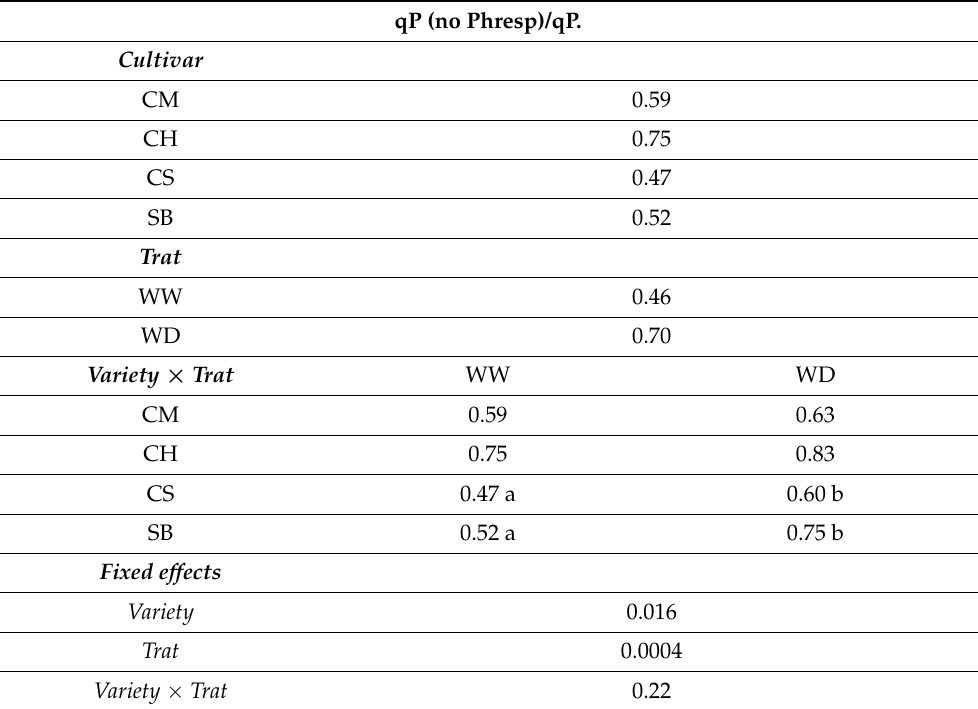
Figure 4. Net CO 2 assimilation responses to light intensity for CM, CH, SB and CS. Dark Colour corresponds to WW and light colour to WD. Error bars represent SE and shaded area is the 95% confidence interval for the mean. Table 2. Relationship between qP under non-photorespiratory conditions and photorespiratory conditions of CM, CH, CS and SB under WD and